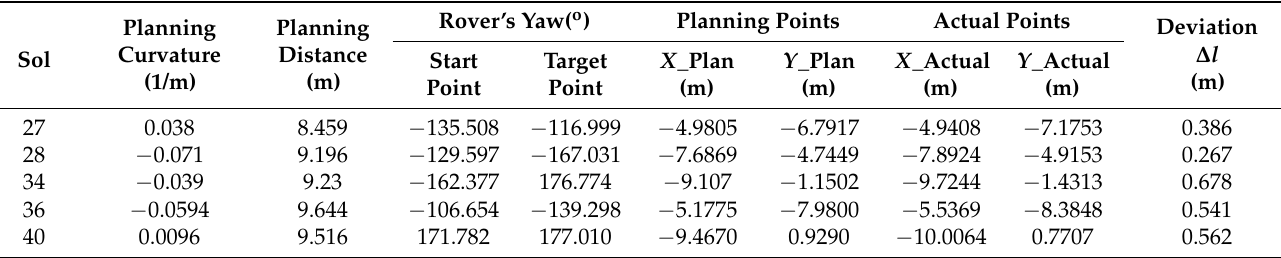
Table 6. Planning end points and actual end points of arrival.